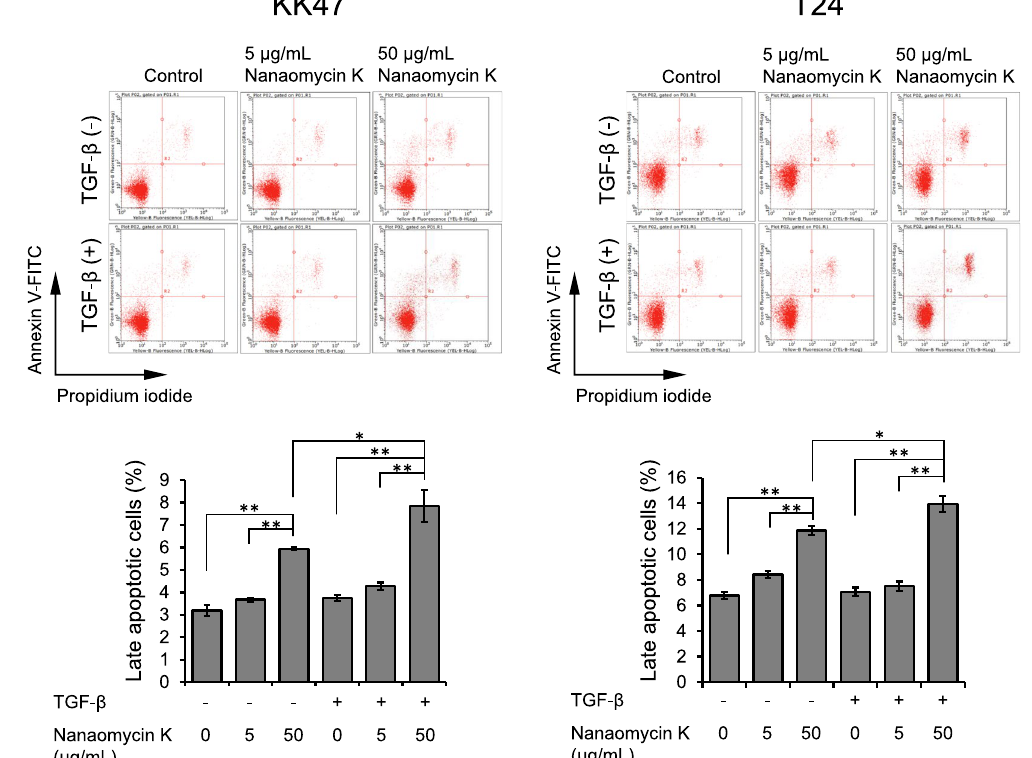
Figure 5. Apoptosis detection. KK47 and T24 cells were treated with nanaomycin K (5 µg/mL or 50 µg/mL) with or without TGF-β in vitro for 48 h and the proportions of late apoptotic cells were detected by Annexin-V- FITC and propidium iodide (PI) (n = 3, average ± SE bars, * p < 0.05, ** p < 0.01). Representative dot plots of each treatment are shown. Data were analyzed by InCyte software (version 3.1, https:// www. lumin excorp. com/ ja/